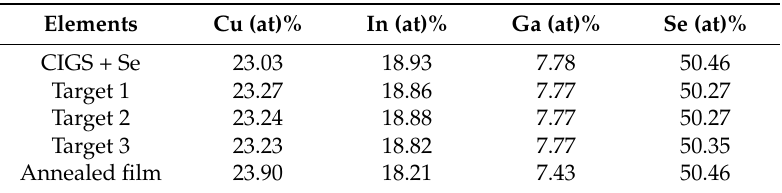
Table 2. The composition of the mixture powder and